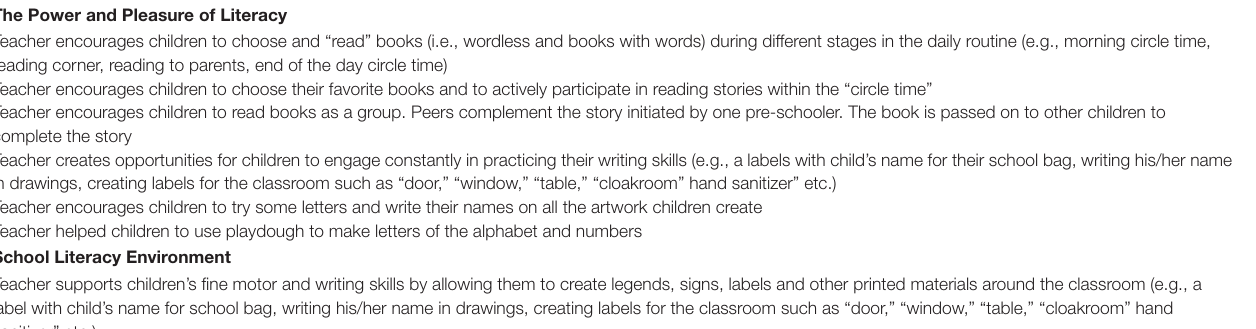
TABLE 1 | List of pedagogical activities implemented in classroom to aid the development of children’s cognitive, social, and fine motor skills. The Power and Pleasure of